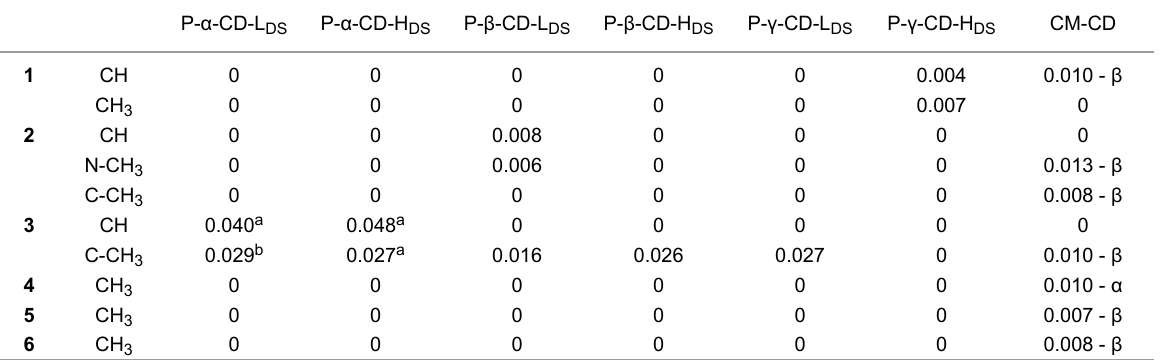
Table 1: Enantiomeric differentiation in ppm in the 1 H NMR spectra (400 MHz) of 1 – 6 (10 mM) with P-CDs and CM-CD [31,32] in D 2 O. The concen- tration of the cyclodextrin is 20 mM unless otherwise